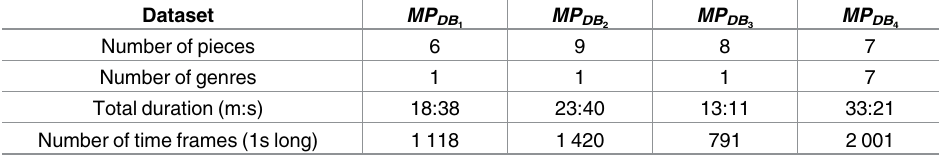
Table 4. Music database: Collection of music pieces used in five different Music Psychology studies and employed in our work for the Arousal and Valence regression